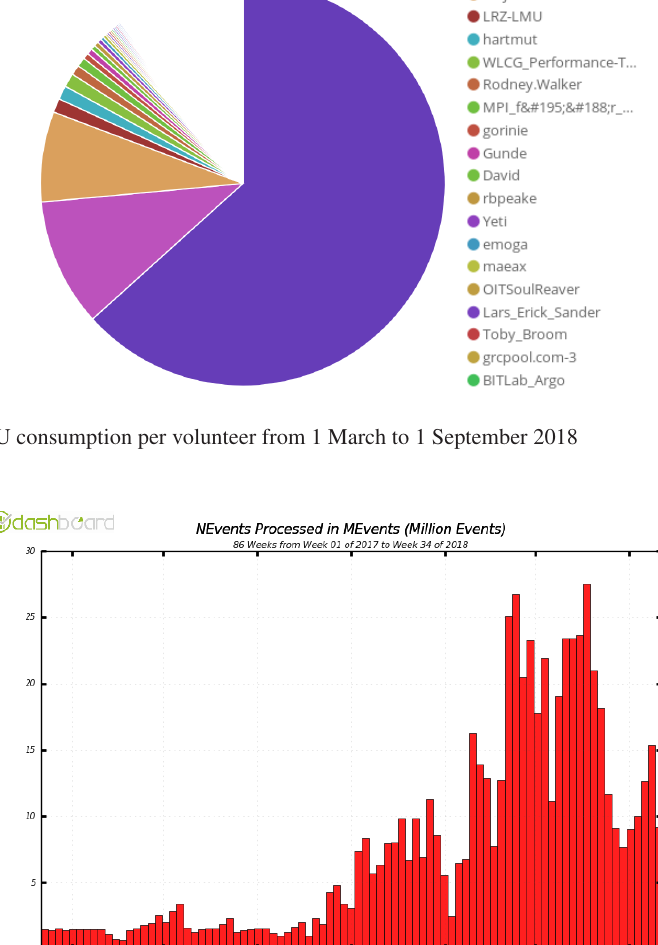
Figure 2. CPU day consumption per version of the ATLAS app during May 2018